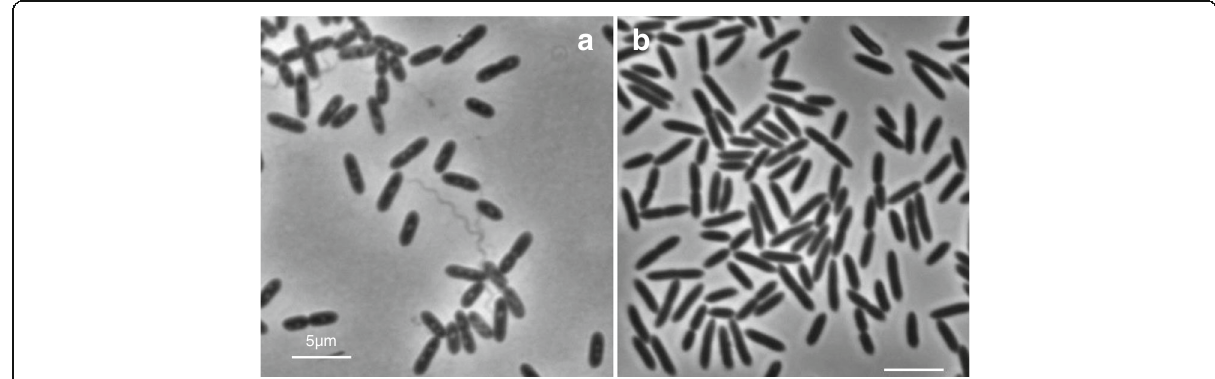
Fig. 1 Phase-contrast micrographs of P. apiarius NRRL B-23460 and P. thiaminolyticus NRRL B-4156. a Depicts P. apiarius NRRL B-23460 cells grown in TSB for 24 hr. at 30 °C. b Depicts P. thiaminolyticus NRRL B-4156 cells grown in TSB for 24 hr. at 37 °C. Scale bars represent 5 μ